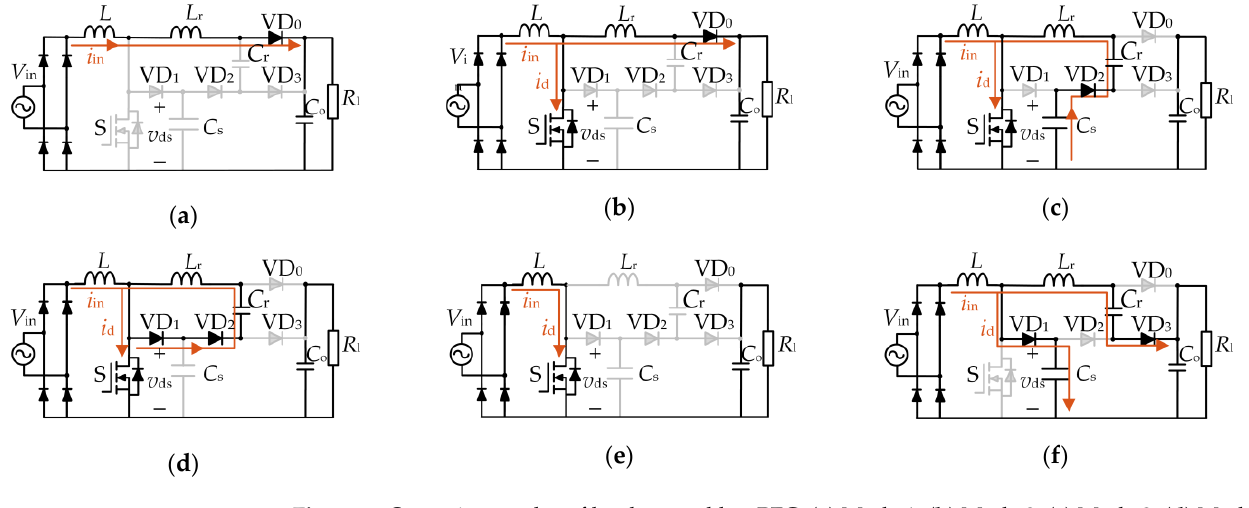
Figure 2. Operating modes of lossless snubber PFC: ( a ) Mode 1; ( b ) Mode 2; ( c ) Mode 3; ( d ) Mode 4; ( e ) Mode 5; and ( f ) Mode 6.